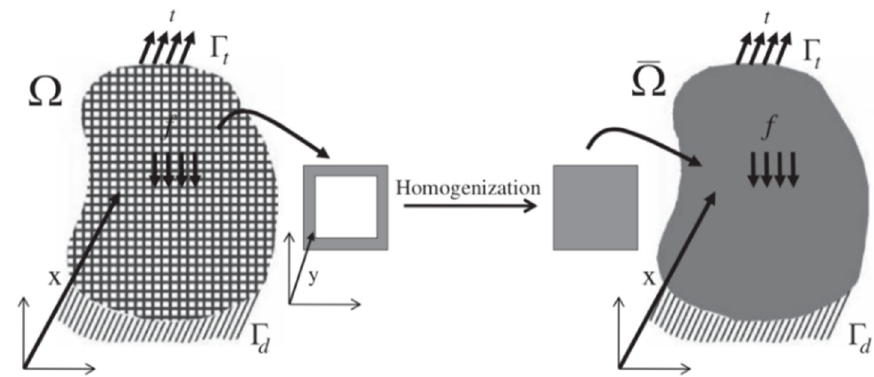
Figure 1. Homogenization concept of a cellular material [1]. Figure 1 . Homogenization concept of a cellular material [1] . Figure 1 . Homogenization concept of a cellular material [1] .